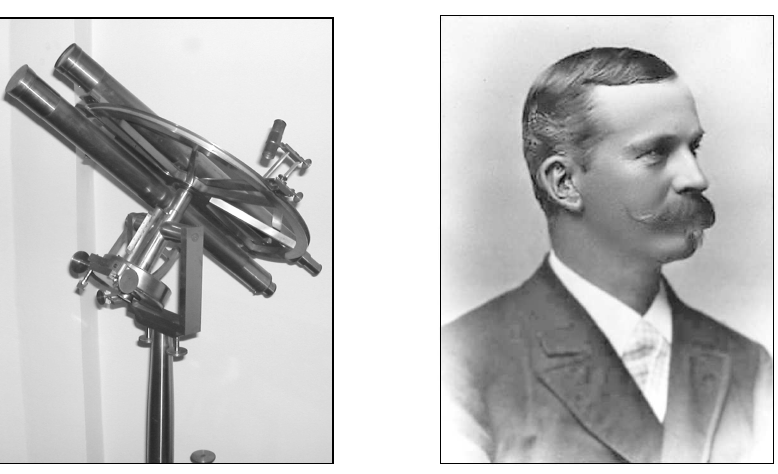
Fig. 6. Repetition circle by Etienne Le- nior from 1801. The instrument was used by J(cid:127)ons Svanberg’s expedition to Lapland in 1802{1803. Image: Michael Lindberg.